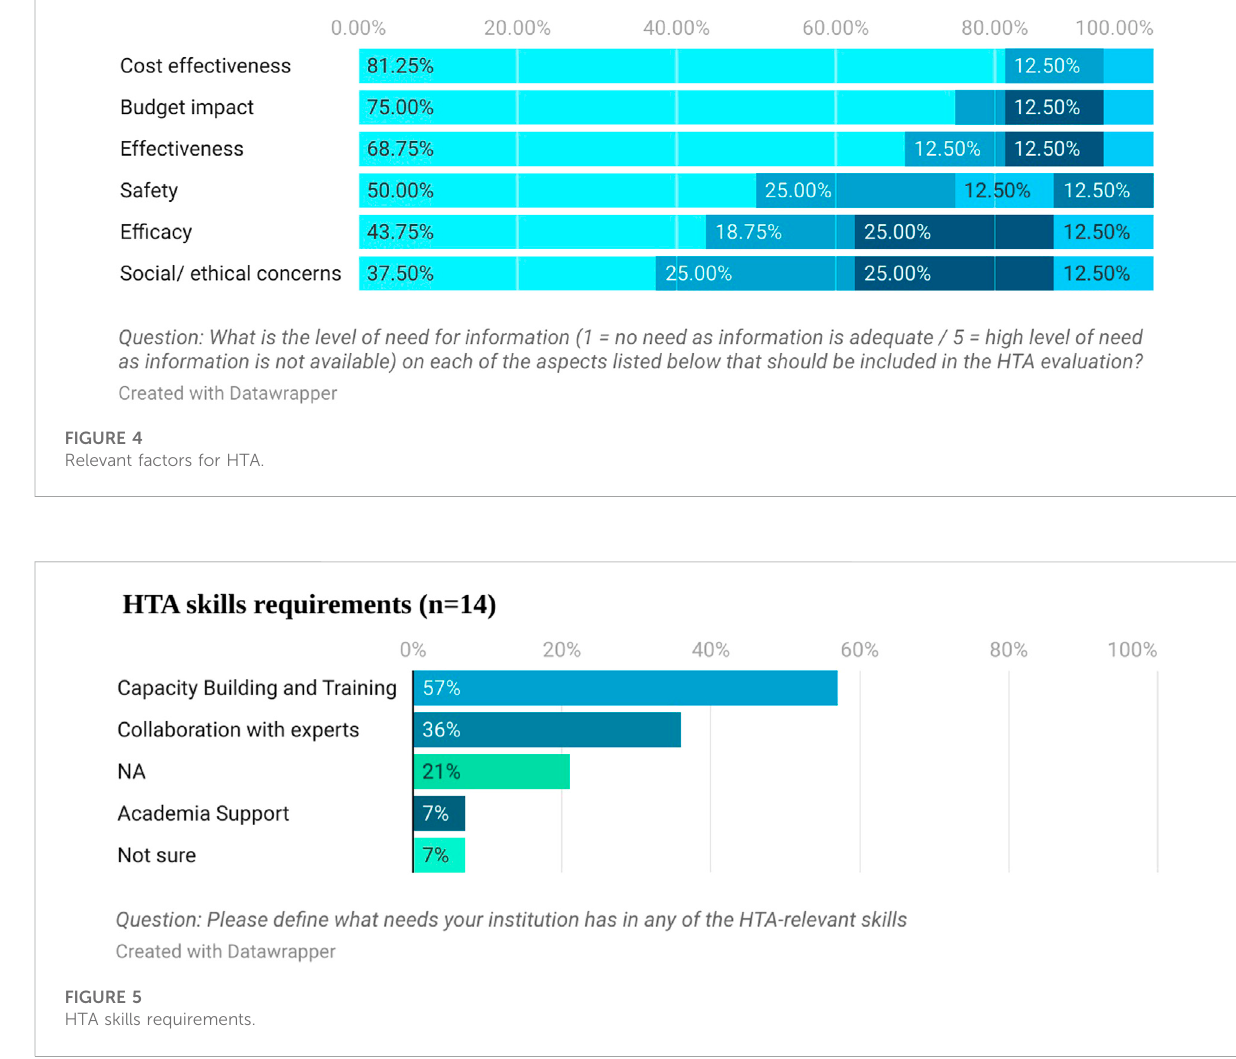
FIGURE 5 HTA skills requirements.